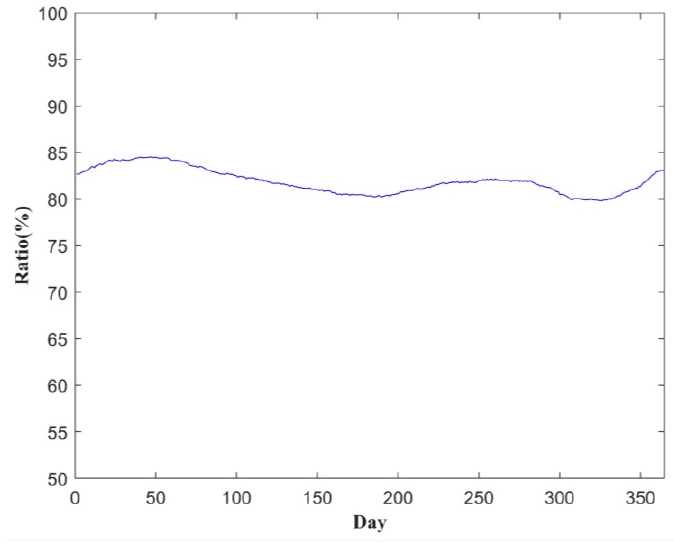
Figure 5. Daily coverage of multisource spaceborne radiometer water vapor data of 2018. The data coverage of the microwave radiometer is defined as the proportion of the effective observation data grid to the global ocean grid.